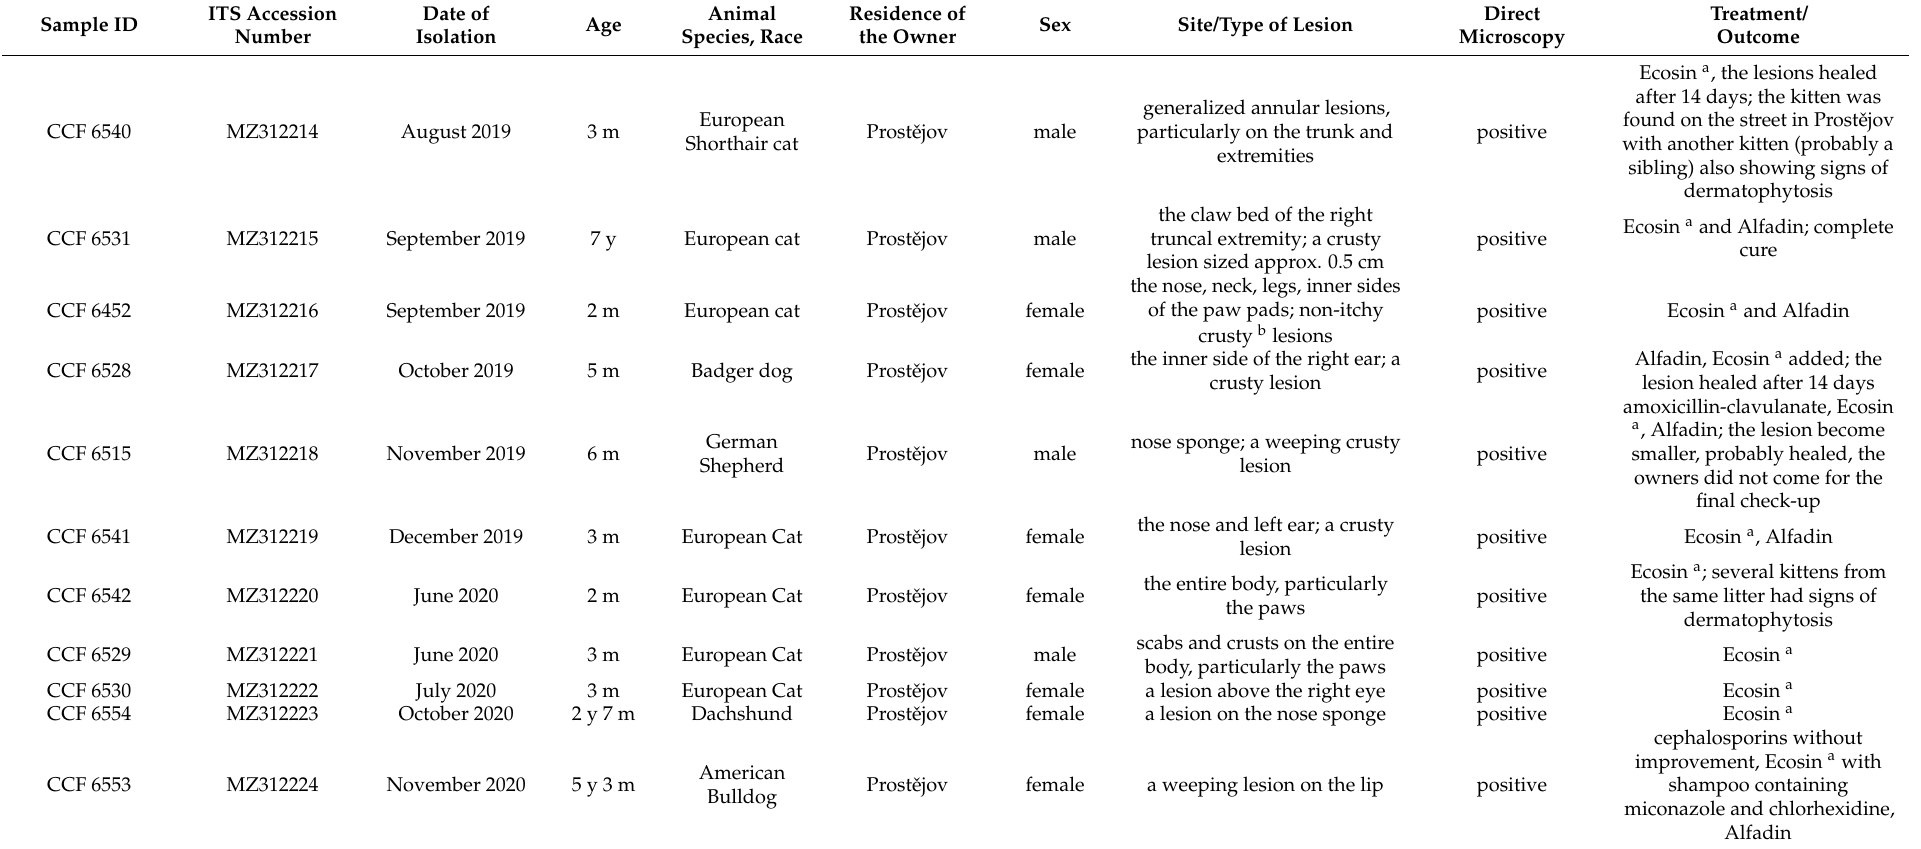
Table 2. Animal isolates of Trichophyton quinckeanum examined in this